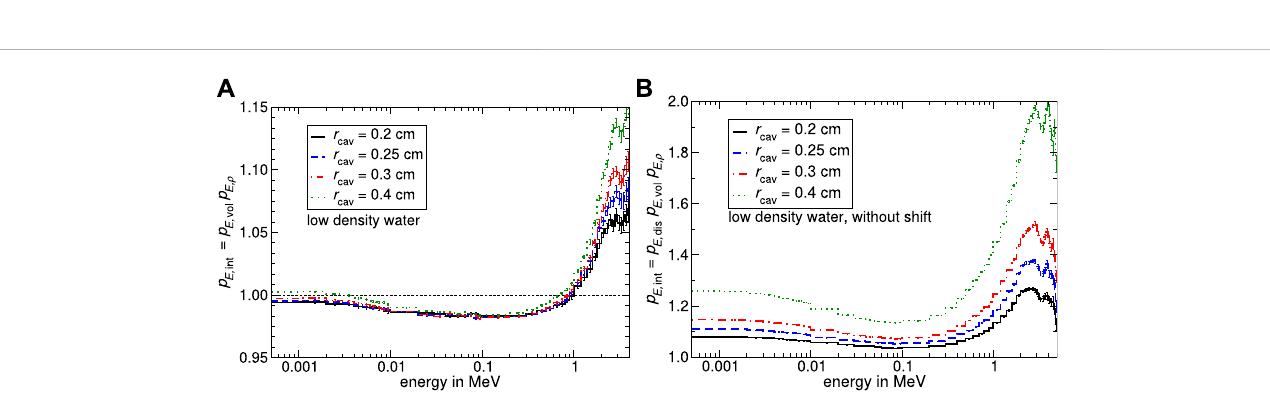
FIGURE 5 Monte Carlo calculated spectral internal fl uence correction factors for a cavity with a length of 0.48 cm and differentradii fi lled with “ low-density water ” as a function of energy at the build-up region. In sub fi gure (A) the cavity was oriented with its axis perpendicular to the beam axis and placed with their reference pointshifted by0.5 · r cav awayfrom thefocus. Inpanel (B) thespectralinternal fl uencecorrectionfactorsareshown, whereby thereference pointis placed at 0.5 cm depth. The uncertainty varies depending on energy in a range of 0.05% – 1.3% for panel (A) and 0.07% – 1.9% for panel (B)